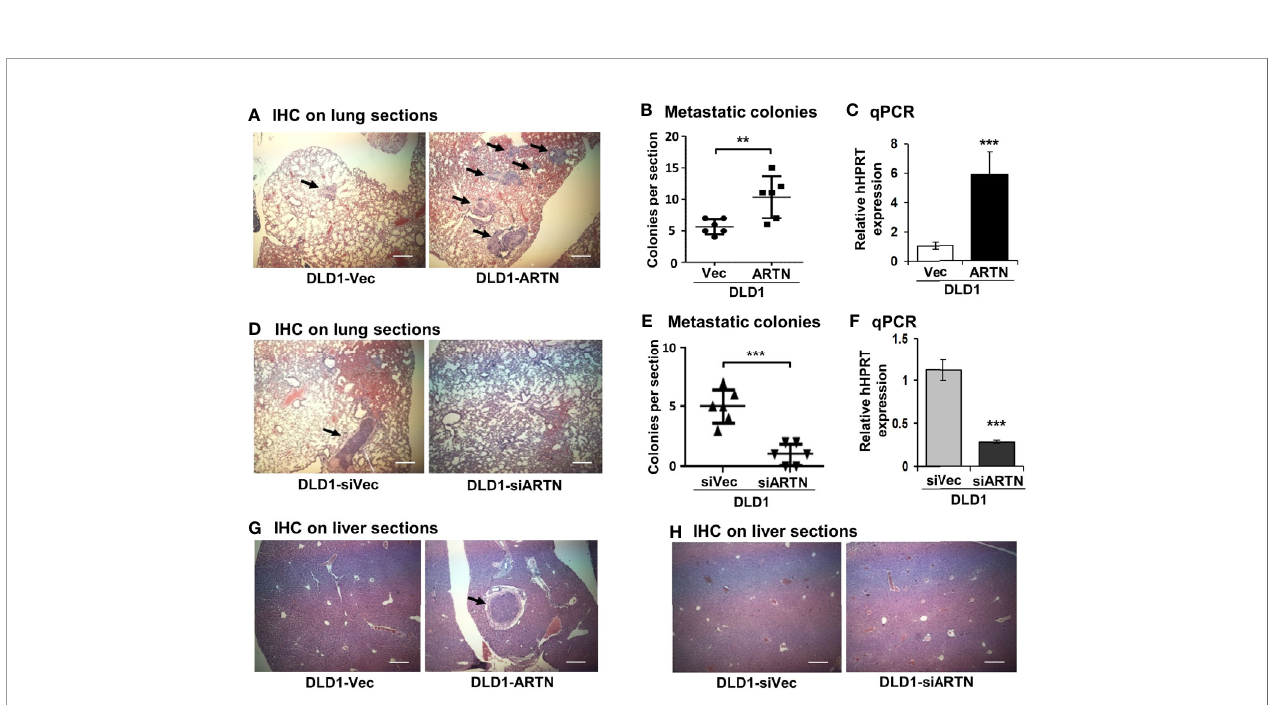
FIGURE 5 | ARTN promotes metastasis of DLD1 cells. (A, D, G, H) , Lung and liver sections from nude mice with tail vein injection of DLD1 cells with stable forced or depleted expression of ARTN (n = 6). The mice were sacri fi ced 6 weeks after injection and the lung and liver from each mouse were harvested. H&E staining was performed on the paraf fi n fi xed lung (A, D) and liver (G, H) sections. The images were taken under a microscope with magni fi cation of 200X. The arrows indicate established metastatic colonies. (B, E) , Numbers of the metastatic colonies in each lung section. (C, F) , The expression of human HPRT gene in the lung sections was quanti fi ed by qPCR with speci fi c primers and normalized against the mouse b -ACTIN . Results were presented in fold change. ** p < 0.01, *** p <